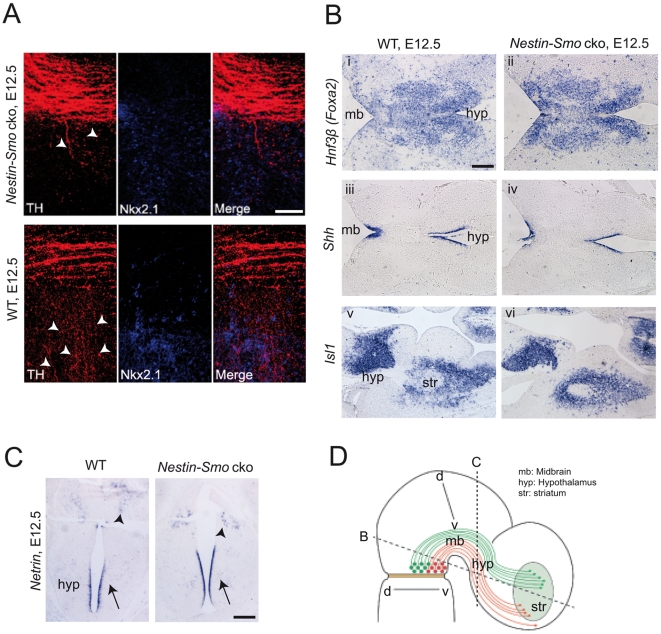
Dopaminergic projection alterations in Smoothened conditional mutant mice do not appear to be a consequence of target tissue defects.(A) At the choice point for rostrally coursing mDN axonal projections (as in Figure 3) the most medial fibers course ventrally (arrowheads in lower left panel) to the embryonic pallidum, subthalamus, and hypothalamus, as indicated by immunostaining with an antibody specific for Nkx2.1. These fibers are deficient in the Nestin-Smo cko mice at E12.5 (arrowheads in upper left panel). (B) Analysis of gene expression by in situ hybridization in the midbrain and target tissues of wild-type and Nestin-Smo cko mice at E12.5. Expression of the target tissue markers Hnf3β (Foxa2; i–ii), Shh (iii–iv), and Islet-1 ( Isl1;v–vi) appear unaltered in the mutant mice, as determined in horizontal sections. Plane of section is indicated in D. (C) Analysis of Netrin1 gene expression by in situ hybridization in the hypothalmus of wild-type and Nestin-Smo cko mice at E12.5. Expression of the chemoattractant Netrin-1 is unaltered in the mutant mice. Arrows indicate ventral midline/floor plate region where Netrin expression is maximal. Arrowheads indicate weak Netrin expression in the thalamus. Plane of section is indicated in D. (D) Schematic of sagittal section of midbrain at E12.5. Scale bars: (A) 100 µm, (B+C) 200 µm.